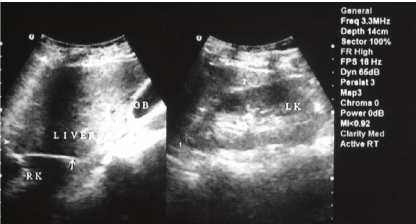
Figure 2: 32-year-old man, diagnosed for ectopic kidney; ultrasonographic evaluation revealed an ectopic right kidney above the right hemidiaphragm. Both kidneys have normal size, echo pattern, and cortical thickness.